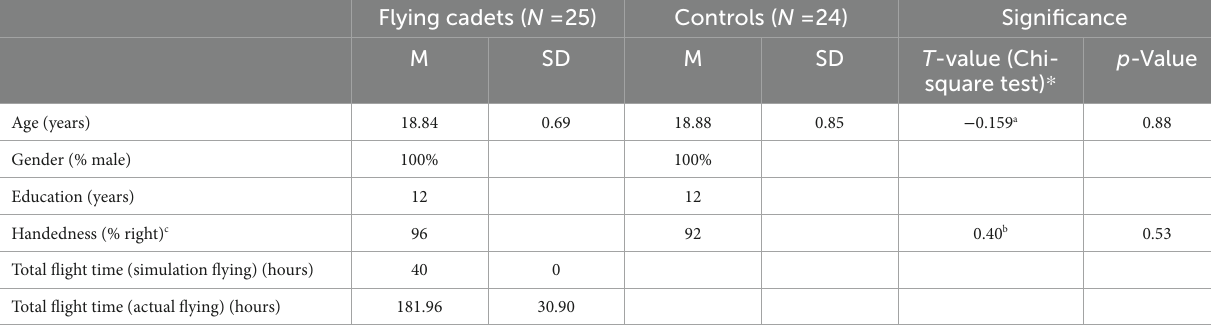
TABLE 1 Demographic characteristics of the two groups at the first time